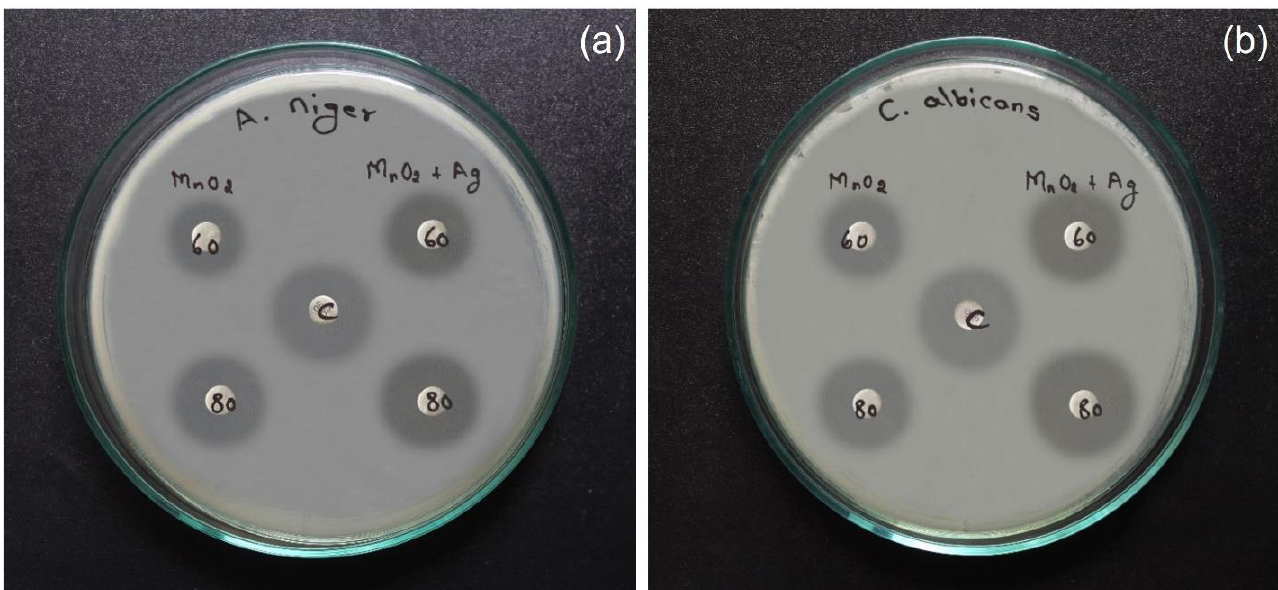
Figure 12. ( a , b ). Antifungal activity of MnO 2 doped with Ag nanoparticles against Aspergillus niger and Candida albicans stains.